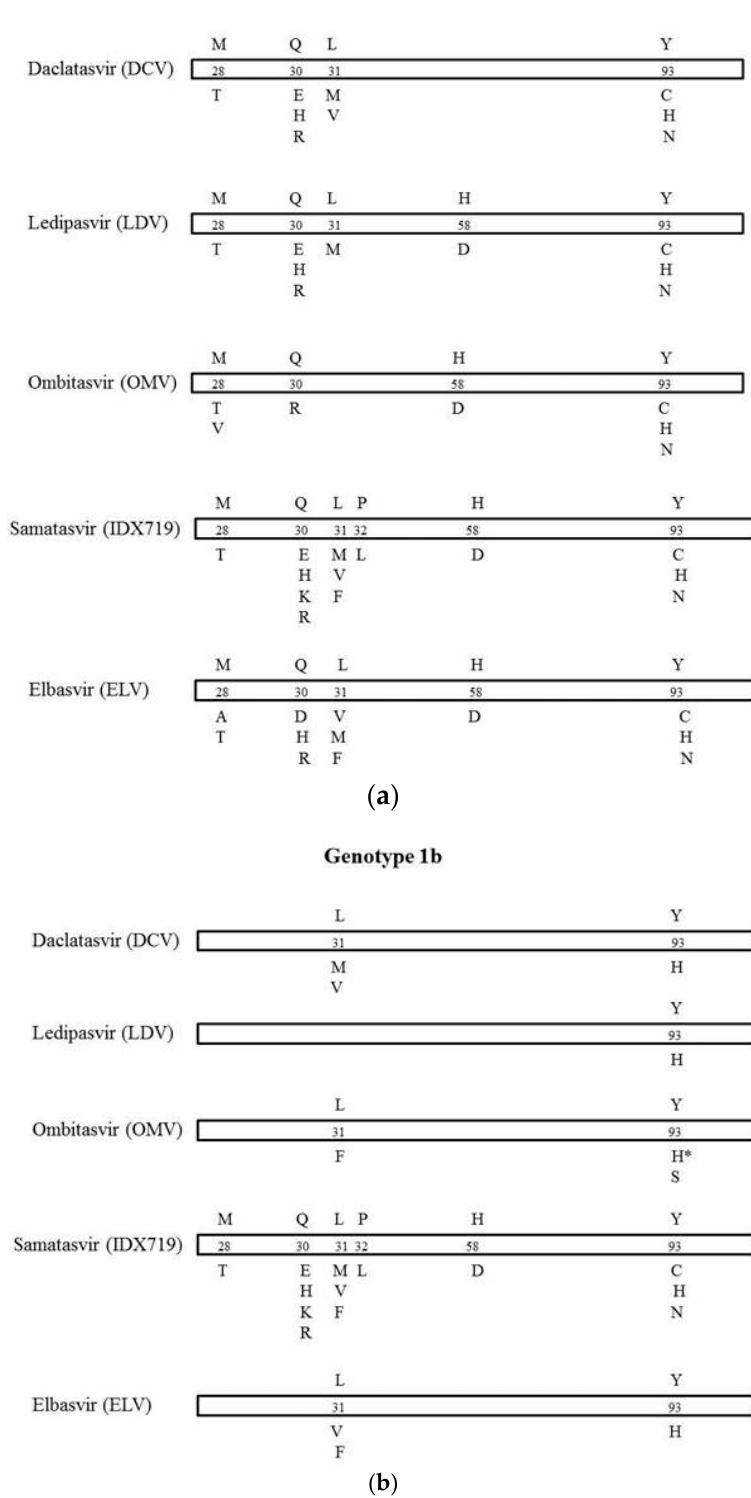
Figure 1. Amino acid substitutions in HCV NS5a domain1 associated with resistance to NS5a inhibitors in clinical use (DCV, LDV, and OMV) or scheduled to come in the near future (IDX719 and ELV) in G1a ( a ) and in G1b ( b ).